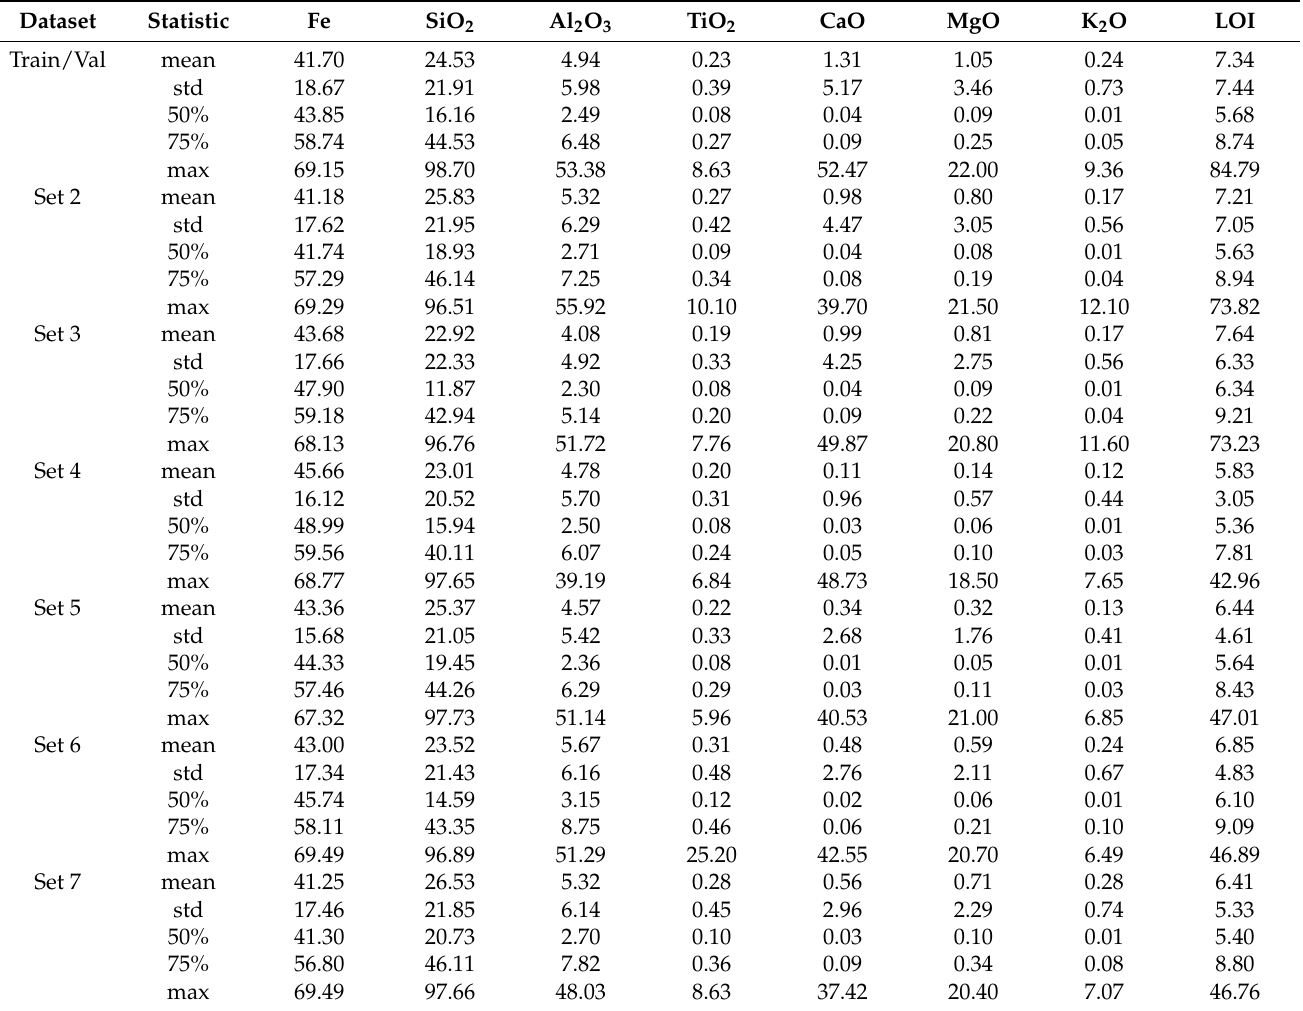
Table 1. The summary statistics comprised of the mean, standard deviation, 50% and 75% quartiles, and the maximum value of the 7 datasets and the 8 geochemical parameters examined in the